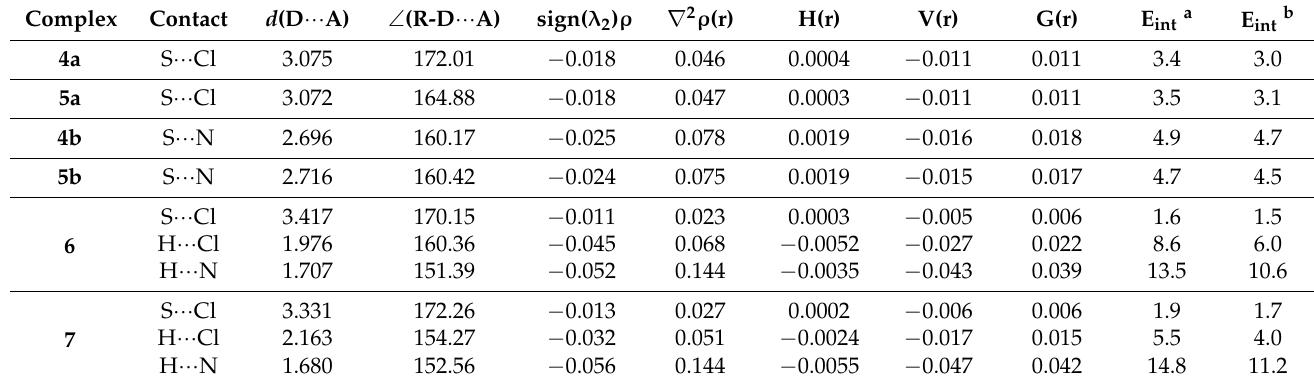
Table 3. Noncovalent interactions in the structures of complexes: geometrical parameters of noncova- lent interactions (Å and deg), values of the density of all electrons multiplied on sign( λ 2 )—sign( λ 2 ) ρ (r), Laplacian of electron density— ∇ 2 ρ (r), energy density—H(r), potential energy density—V(r), and Lagrangian kinetic energy—G(r) (a.u.) at the BCPs (3, –1), energies of noncovalent interactions defined by two